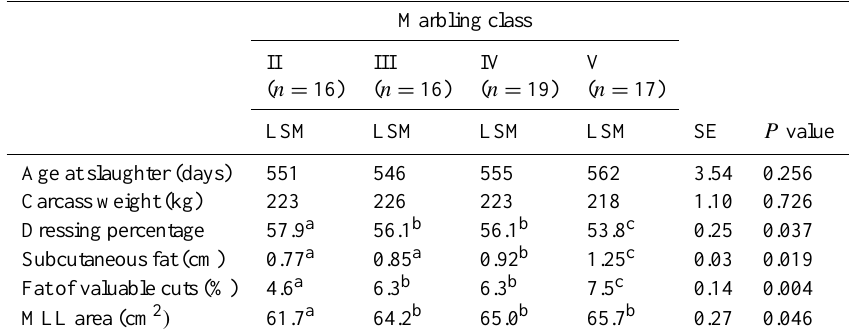
Table 1. Slaughter traits and carcass analysis.